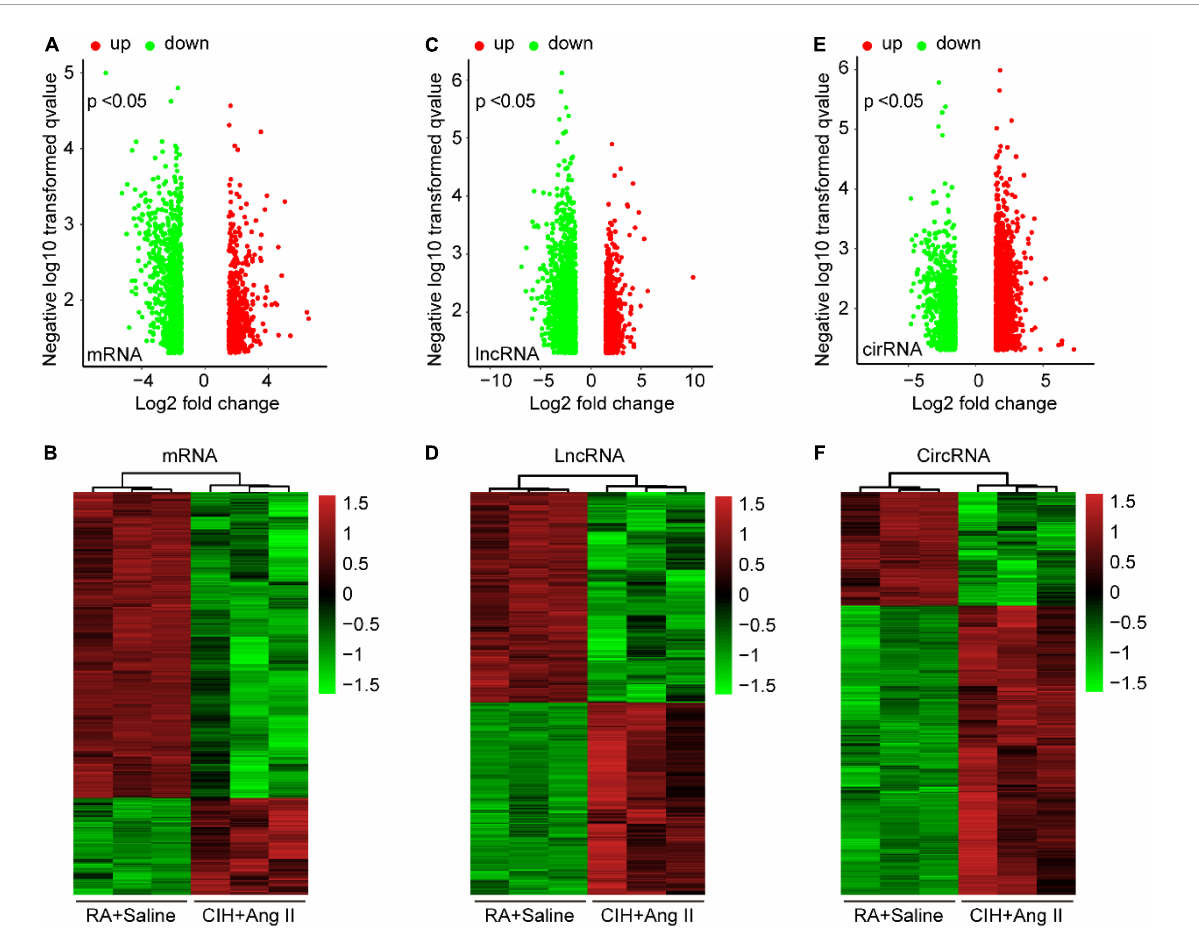
FIGURE3 Volcano plots and heatmaps of differentially expressed (DE) mRNAs, long-non-coding RNAs (lncRNAs), and circular RNAs (circRNAs) in aortic dissection (AD) and normal tissues. (A,C,E) Volcano plots of DE mRNAs (A) , lncRNAs (C) , and circRNAs (E) in the ceRNA microarray; green and red points represent down- and upregulated transcripts, respectively; (B,D,F) The heatmap of DE mRNAs (B) , lncRNAs (D) , and circRNAs (F) in the ceRNA microarray. From panels (A–F) , log (fold change) ≥ 1.5 or ≤ -1.5, P < 0.05.